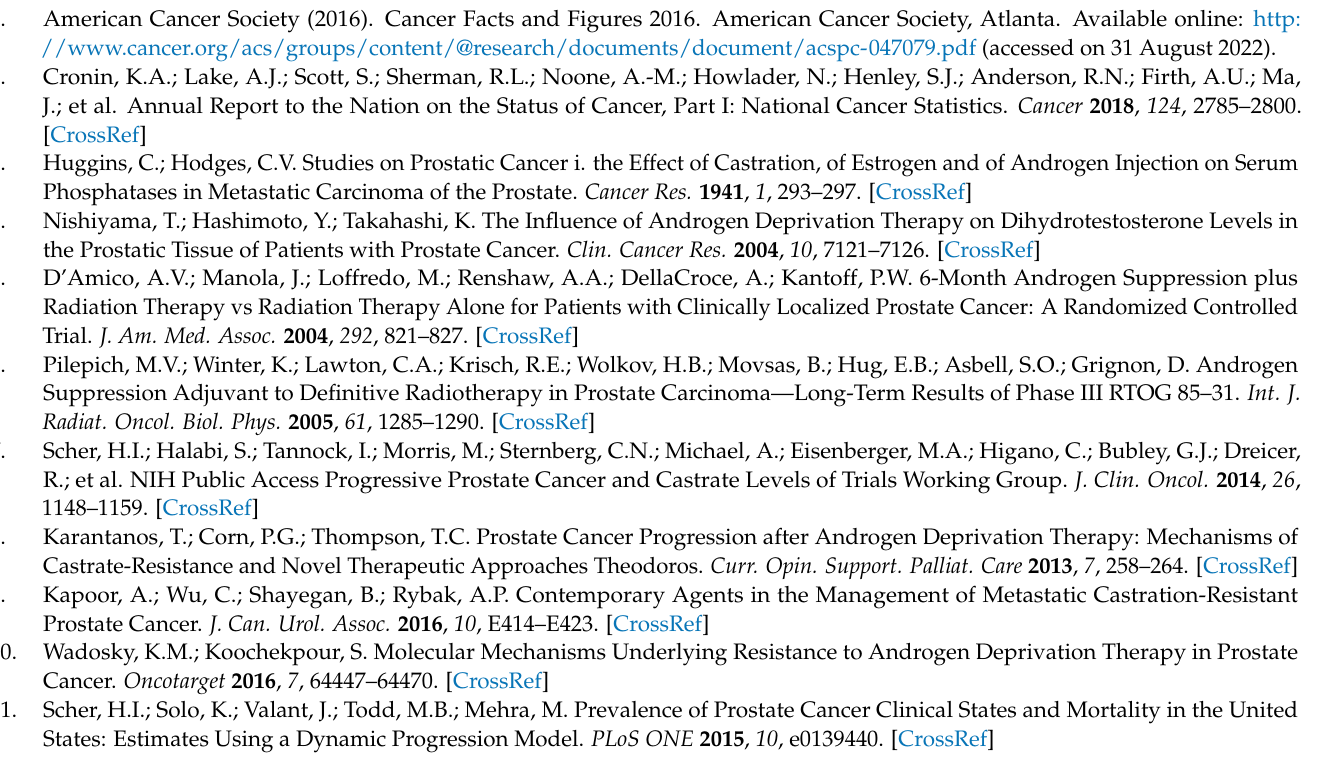
predictions. Figure S7: Pathway enrichment showing FK866 treatment impacted JAK-STAT signaling pathway. Figure S8: Original Western Blots for Figure 4C. Supplementary Figure S9: Original Western Blots for Figure 9D; Table S1: List of Drugs, reagents, antibodies, and kits. Table S2: Top differentially expressed genes (DEGs) (fold change compared to untreated) following 48 h of Fk866, FK866 + DTX and DTX treatment in PC-3, PC-3M and DU145 (AI-mCRPC/NEPC) cell lines (Fold change > 2; p < 0.05). Table S3: Prostate cancer patient dataset details. Table S4: List the genes that